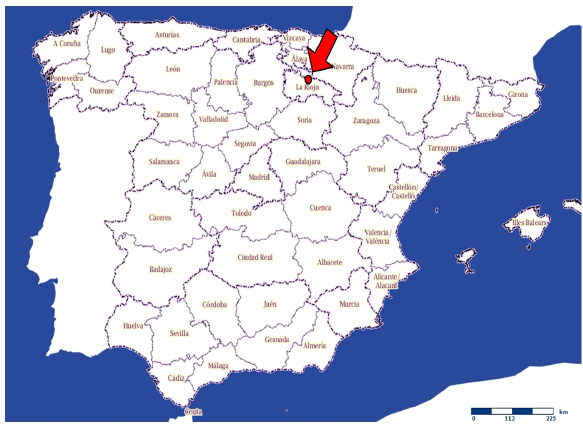
Figure 3. Location of the Monastery in the Iberian Peninsula